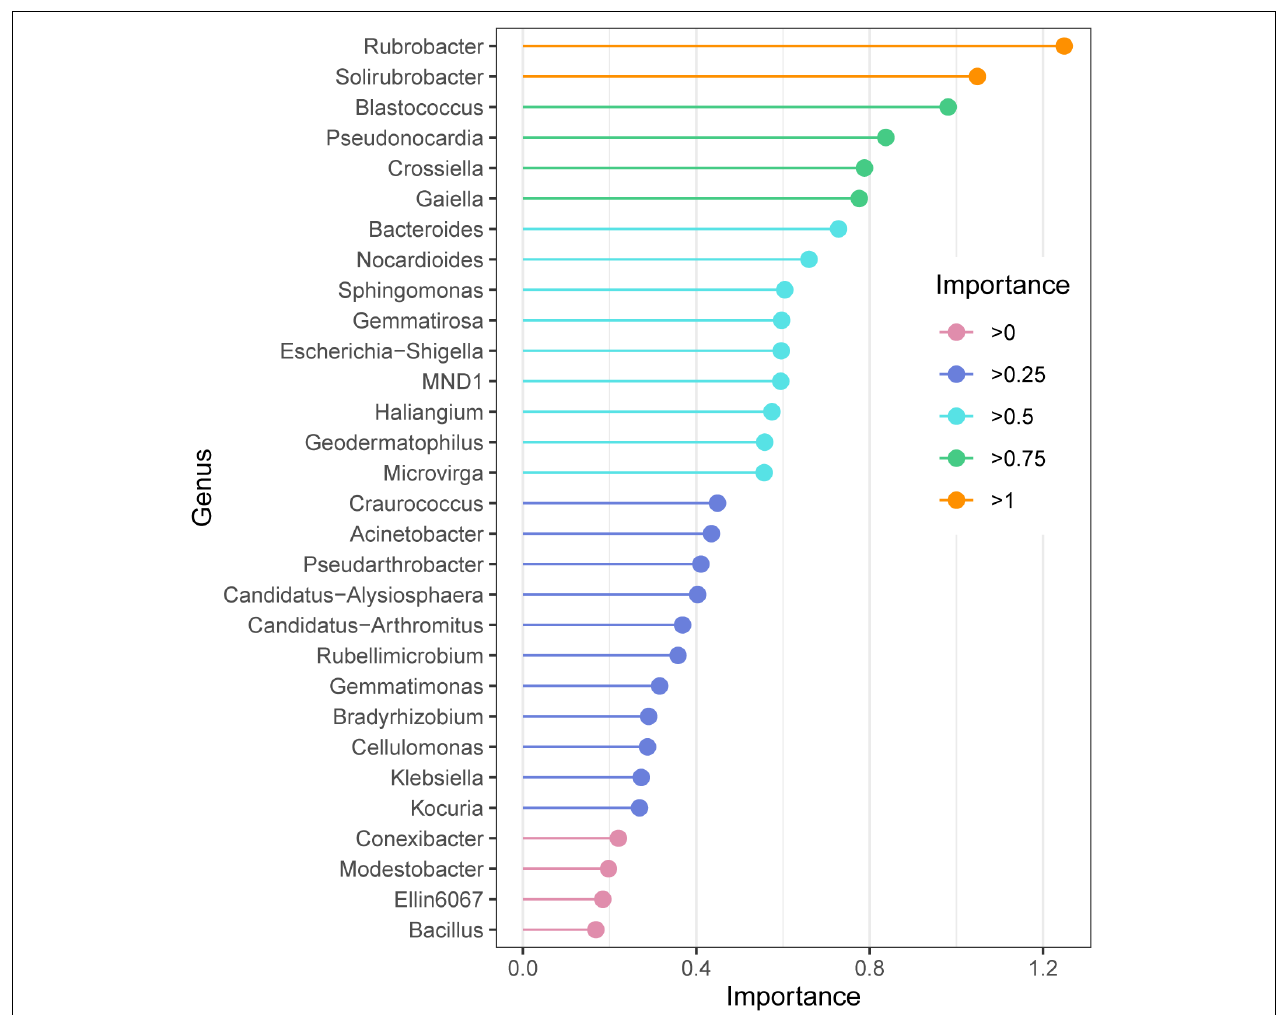
FIGURE 4 | Species importance point map according to the importance of the top 30 soil bacteria at the genus level of alpine grasslands on the Tibetan Plateau. TABLE 1 | Alpha diversity indices of soil bacterial communities (mean ± SE) in alpine grasslands on the Tibetan Plateau. Alpine grasslands PD whole tree Chao1 *Goods coverage Observed species Shannon Simpson